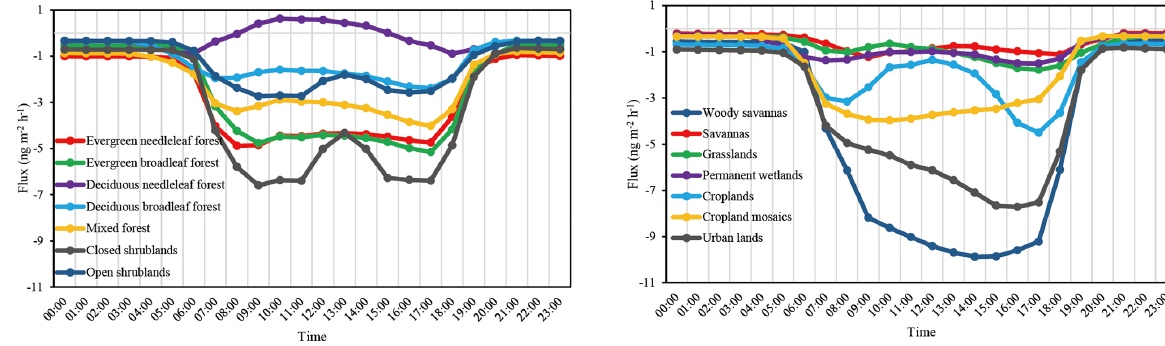
Figure 4. Diurnal variation of mean simulated exchange fluxes of Hg 0 over canopy in the model domain (UTC + 8).